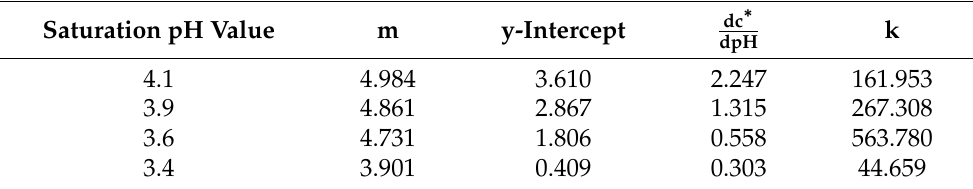
Table 2. Determined nucleation parameters of succinic acid for electrochemically induced pH-shift